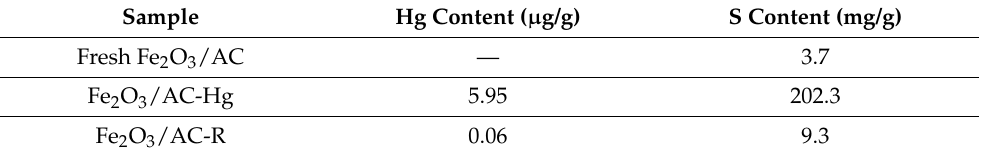
Table 2. Analysis of Hg and S contents before and after regeneration of Fe 2 O 3 /AC.